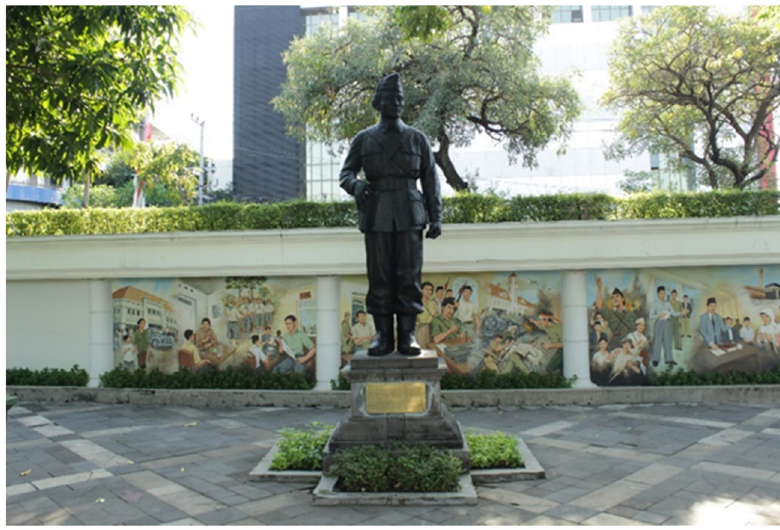
Figure 9: Paintings and statue of one of the Indonesian national fi gures in Museum 10 November.